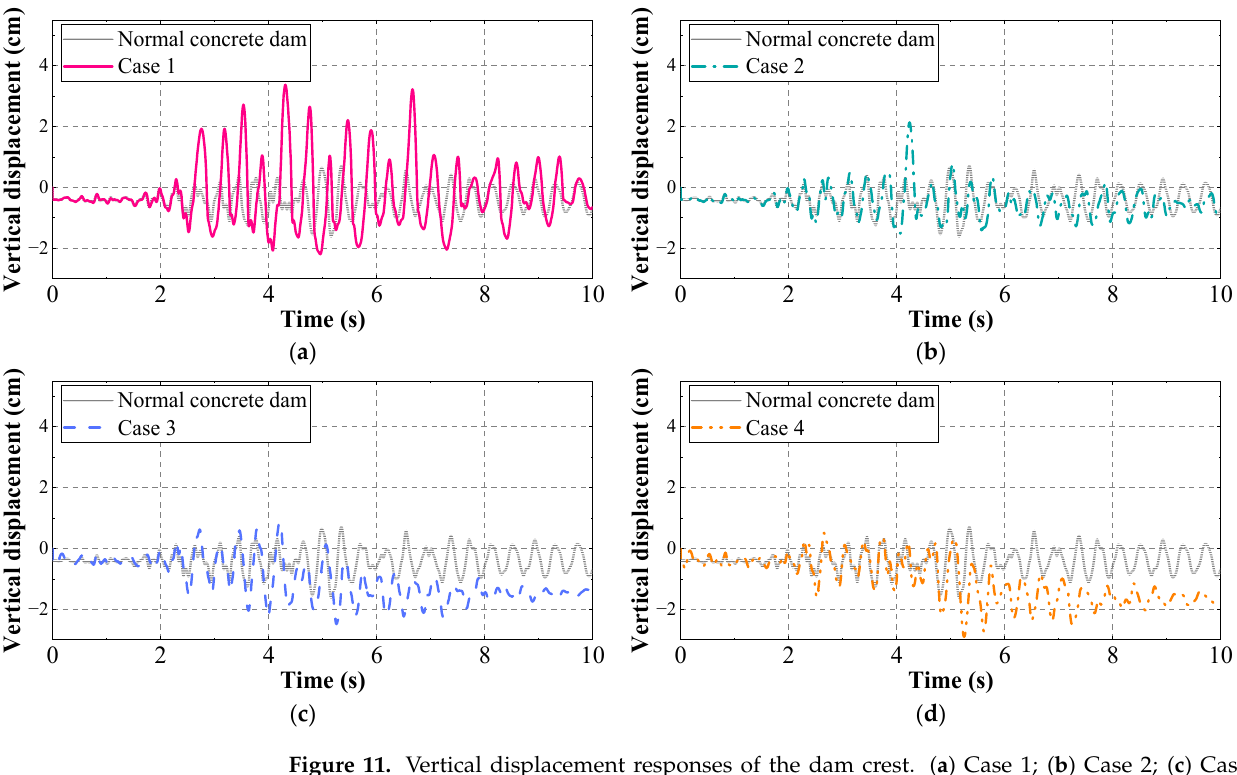
Figure 11. Vertical displacement responses of the dam crest. ( a ) Case 1; ( b ) Case 2; ( c ) Case 3; ( d ) Case 4.